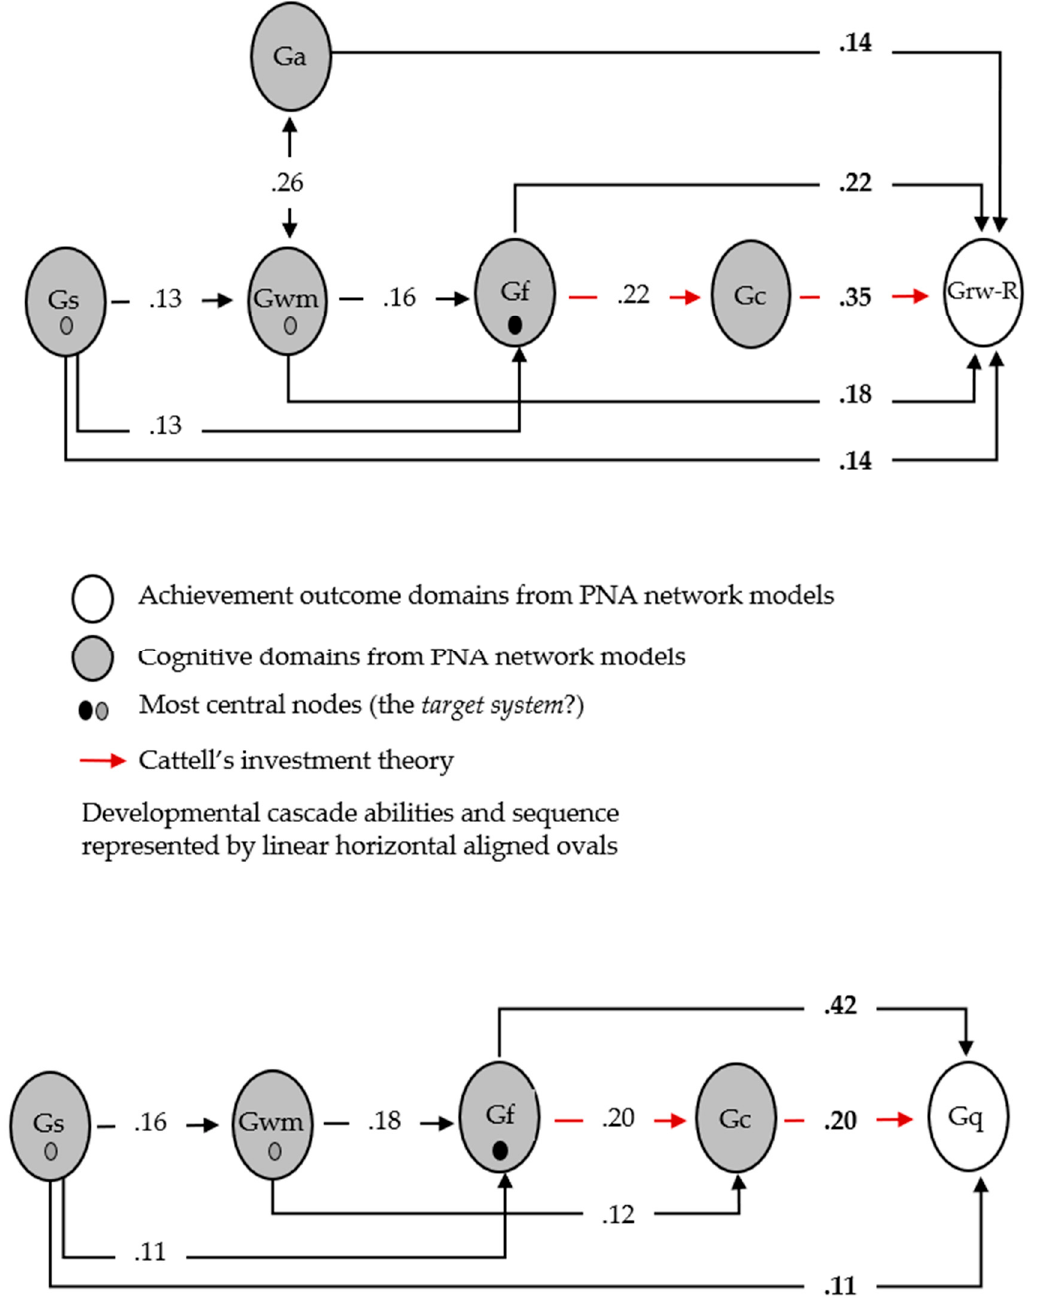
Figure 3. CHC cognitive, reading, and math composite variables (and weights) from Figures 1 and 2 as organized as per the developmental cascade and Cattell investment theories. Note . Bold font indicates direct cognitive path links to achievement composite measures.